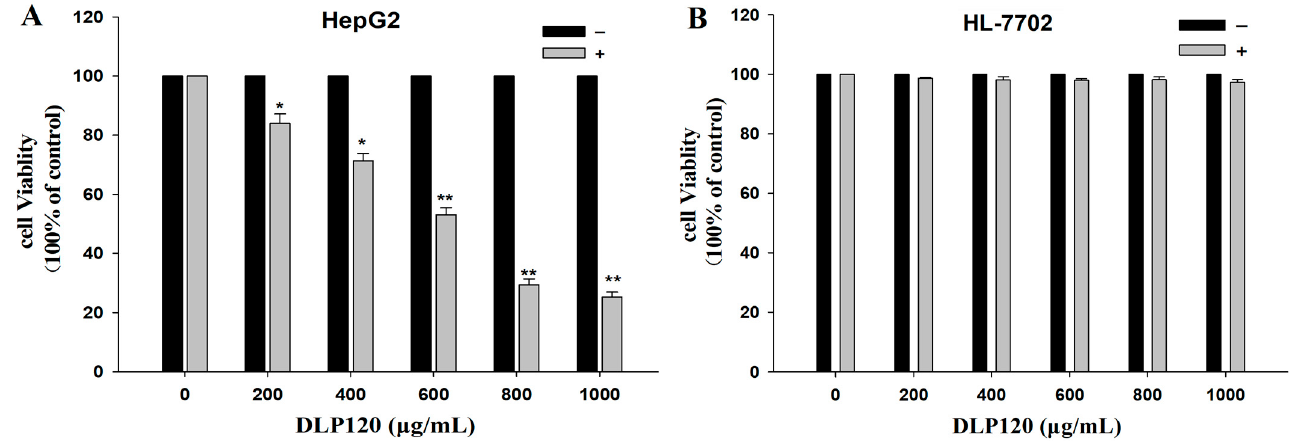
Figure 4. MTT results of DLP120 on HepG2 cells ( A ) and HL-7702 cells ( B ) at 24 h. * p < 0.05 ** p < 0.01 vs. control.